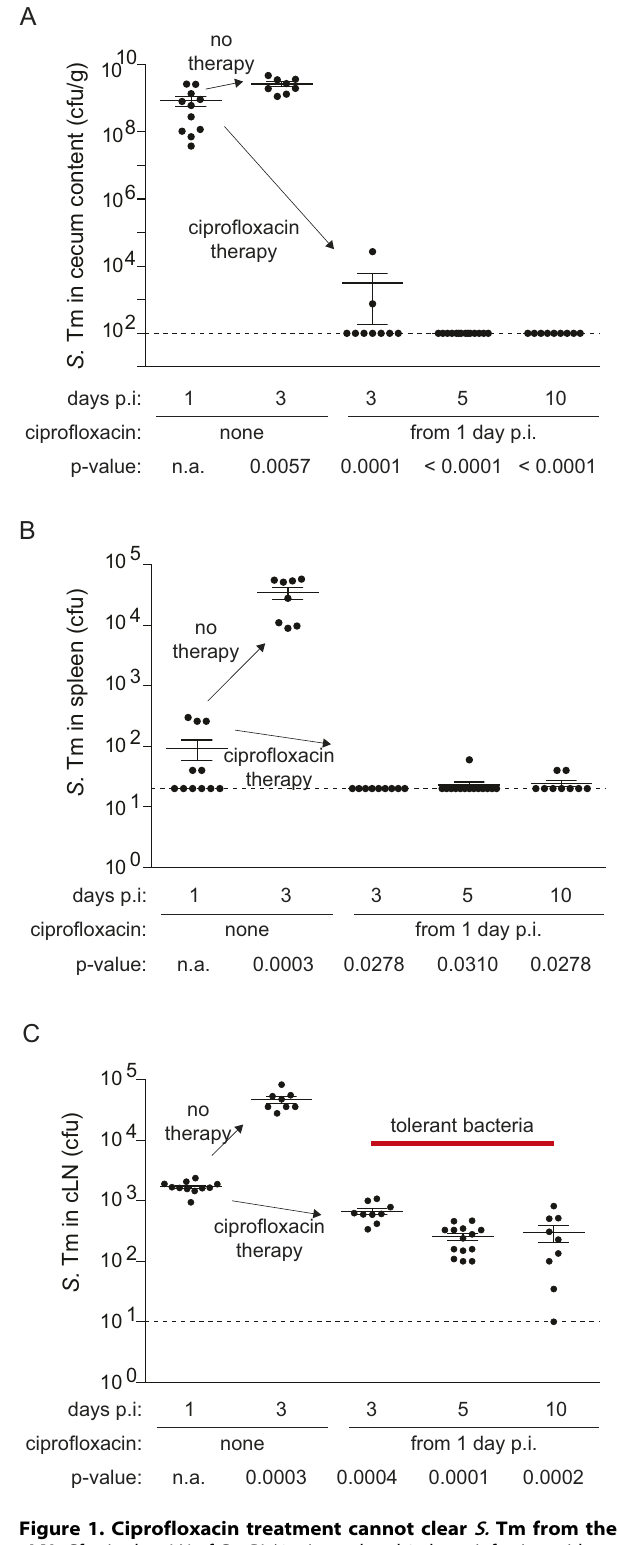
Figure 1. Ciprofloxacin treatment cannot clear S. Tm from the cLN. Cfus in the cLN of C57BL/6 mice 1 d and 3 d postinfection without therapyor3 d,5 d, and 10 d p.i. withciprofloxacintherapy (2 6 62 mg/kg/ d by gavage) starting 1 d p.i. Each symbol represents one mouse. (A), cfu in stool from cecum lumen; (B), cfu in spleen; (C), cfu in cLN; dashed line, detection limit. p , nonparametric statistical analysis compared to 1 d p.i.